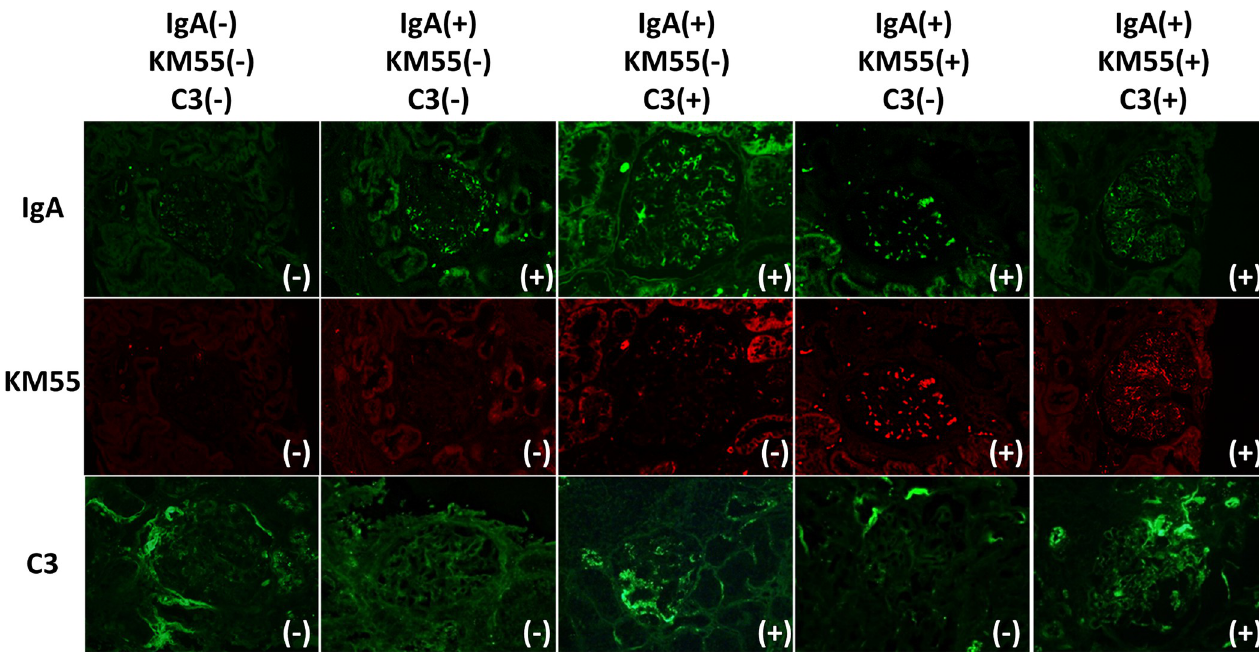
Fig 1. Immunostaifning characteristics in the subgroups. IgA, immunoglobulin A; IgA( − ), IgA-negative group; IgA(+), IgA-positive group; KM55( − ), KM55-negative group; KM55(+), KM55-positive group; KM55( − )C3( − ), KM55-negative/C3-negative group; KM55( − )C3(+), KM55-negative/C3-positive group; KM55(+)C3( − ), KM55-positive/C3-negative group; KM55(+)C3(+), KM55-positive/C3-positive